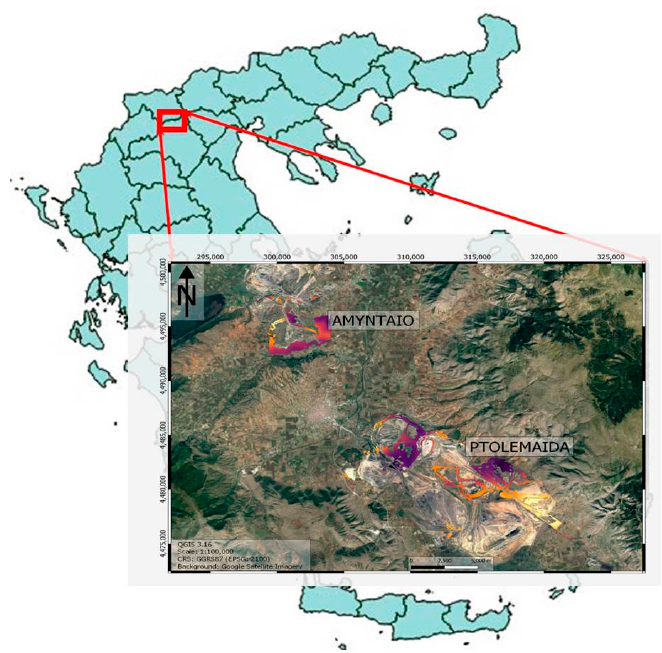
Figure 1. Location of the study area in Greece. Colored polygons indicate the studied restoration plantations of black locust in Amyntaio and Ptolemaida mine fields.